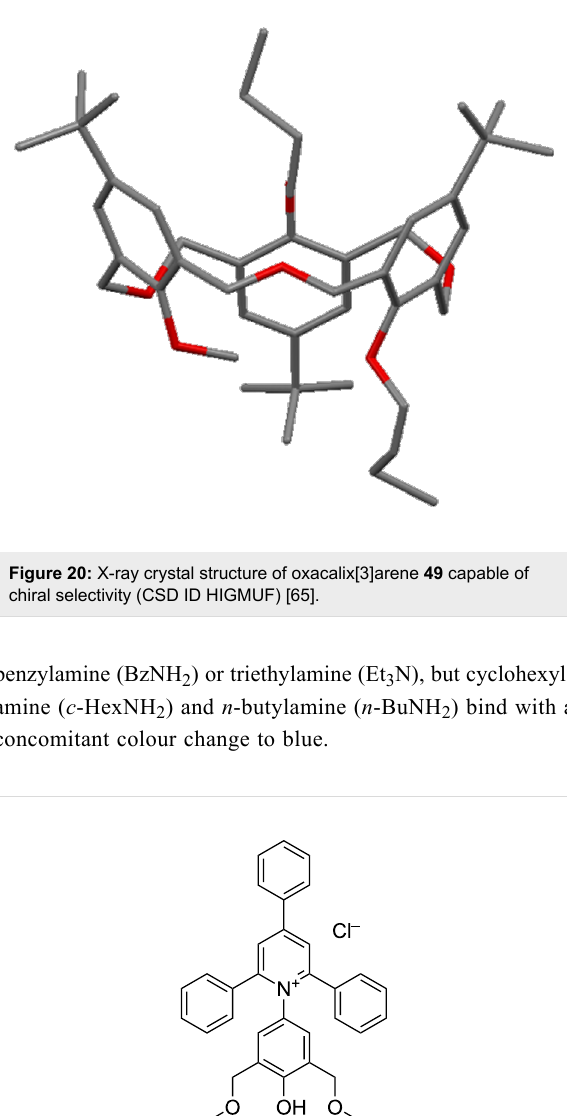
Figure 21: The structure of derivative 50 incorporating a Reichardt dye [66].